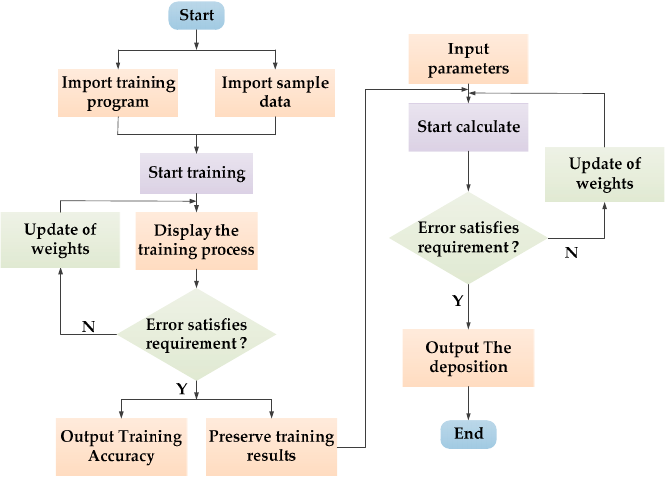
Figure 17. The software workflow diagram.